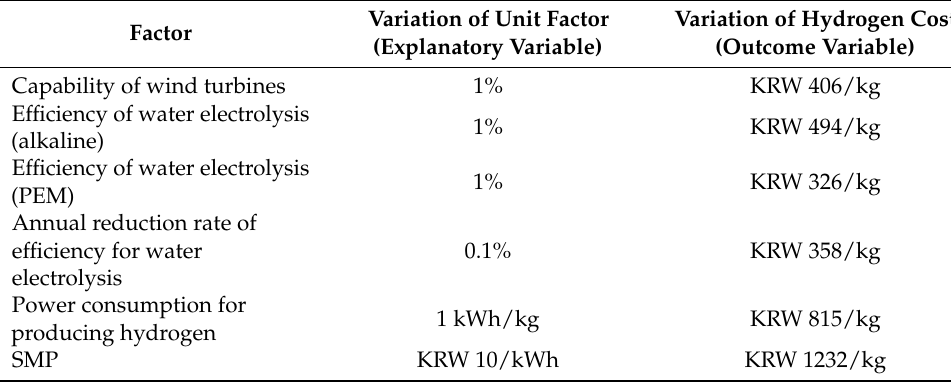
Table 29. Summary of sensitivity analysis.